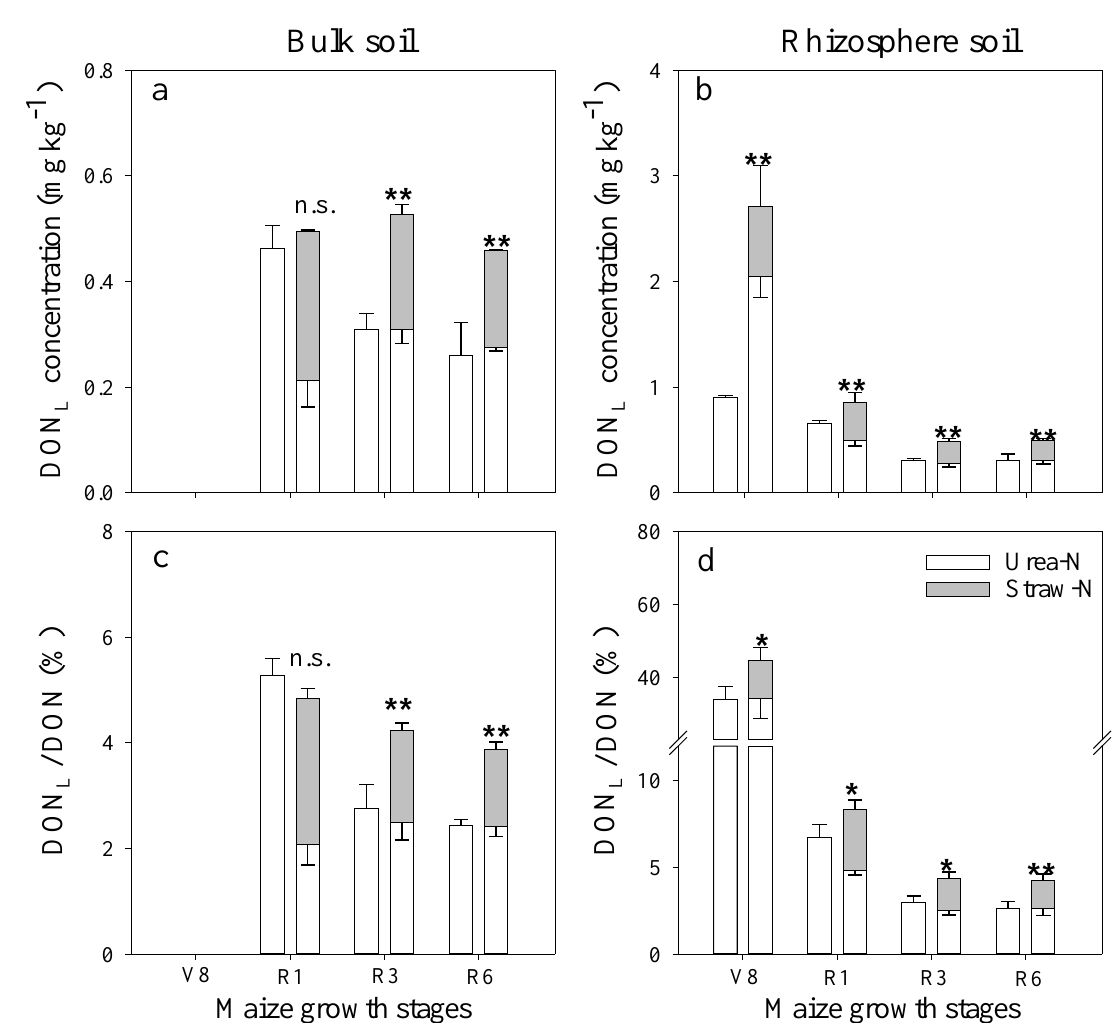
Figure 5. Concentration ( a , b ) and percentage ( c , d ) of labeled applied N (N L ) present as dissolved organic N (DON) in bulk and rhizosphere soil in different fertilizer treatment during maize growth. White-only bars represent urea treatment (U). White plus gray bars represent urea combined with straw treatment (US). Maize growth stage: V8, R1, R3, and R6 respectively represent 8th leaf stage, silking stage, milk stage, and physiological maturity. Data shown are mean ± standard deviation of three replicates; * and ** denote significant differences at p < 0.05 and p < 0.01, respectively; n.s., not significant ( p > 0.05). Not detected in bulk soil at the V8 stage.